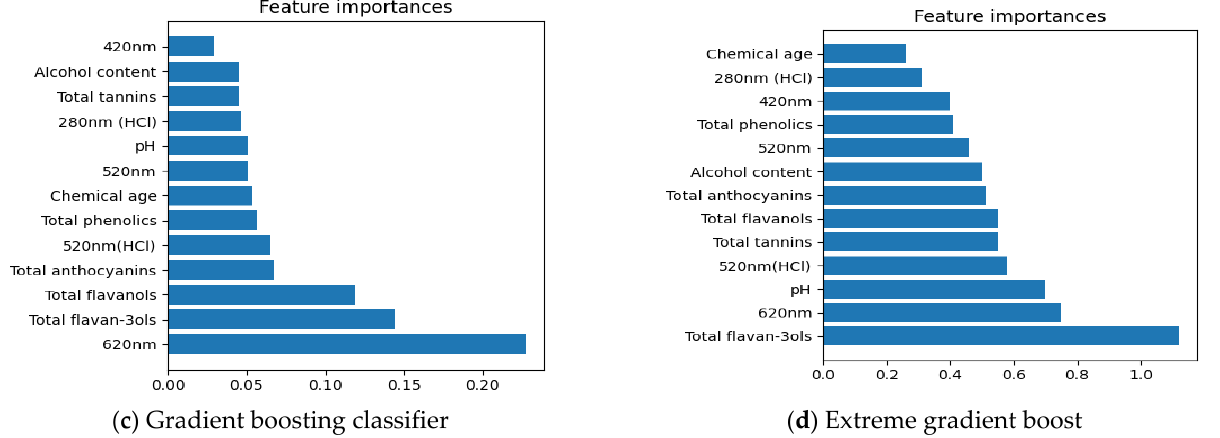
Figure 2. Features selection of 13 chemical data using Random Forest (RF), Extra trees classifier, Gradient boosting classifier, and Extreme gradient boost (XGBOOST) in regions of origin. ( a – d ) display the important chemical parameters in regions of origin that are selected by Random Forest, Extra trees classifier, Gradient boosting classifier and Extreme gradient boost, respectively.